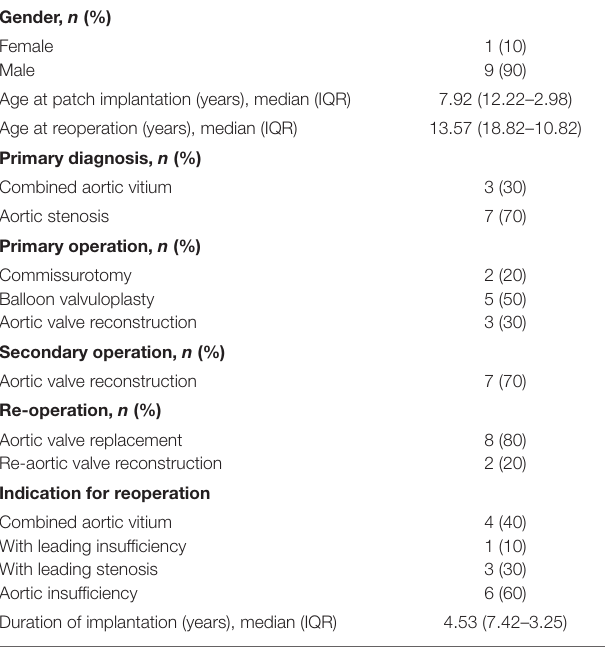
TABLE 1 | Patient characteristics. Gender, n